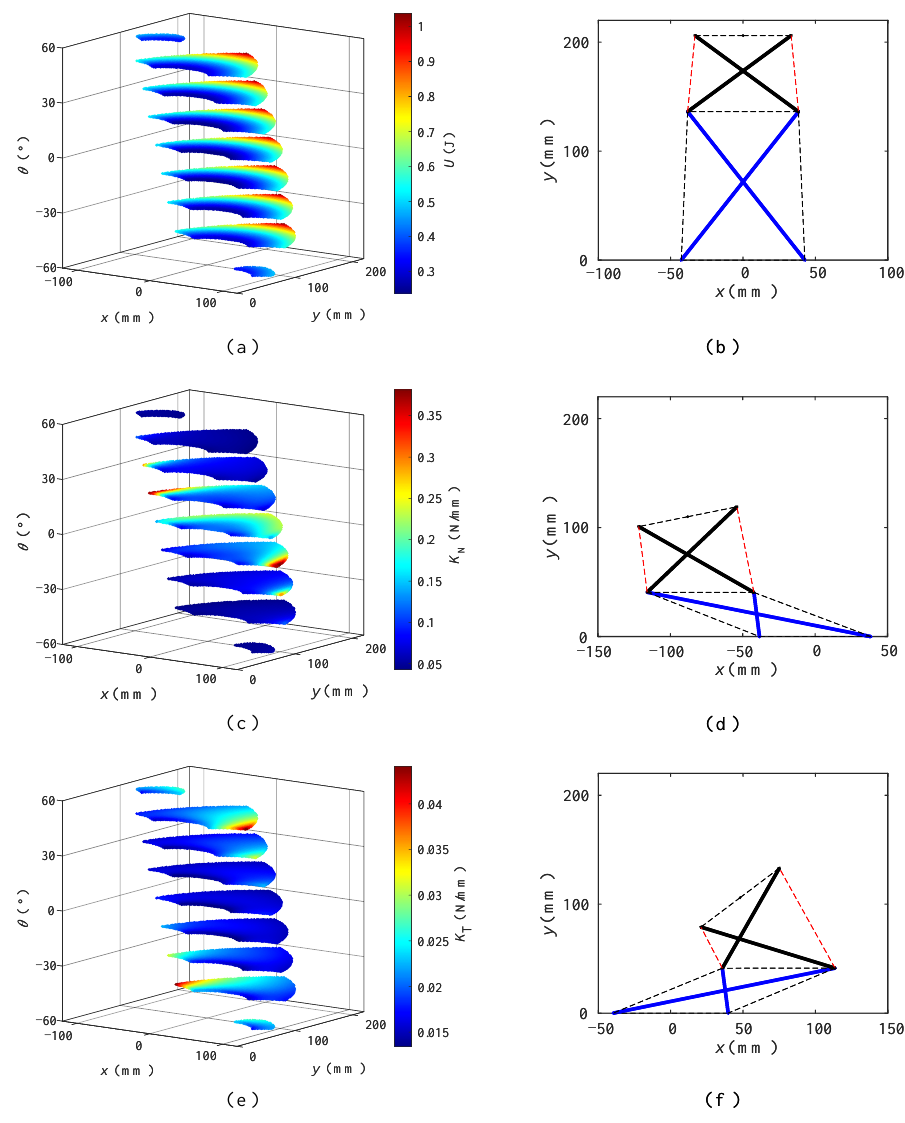
Figure 8. Potential energy and stiffness of end-effector. ( a ) Potential energy. ( b ) Maximum potential energy state. ( c ) Normal stiffness of end-effector. ( d ) Maximum normal stiffness state. ( e ) Tangential stiffness of end-effector. ( f ) Maximum tangential stiffness